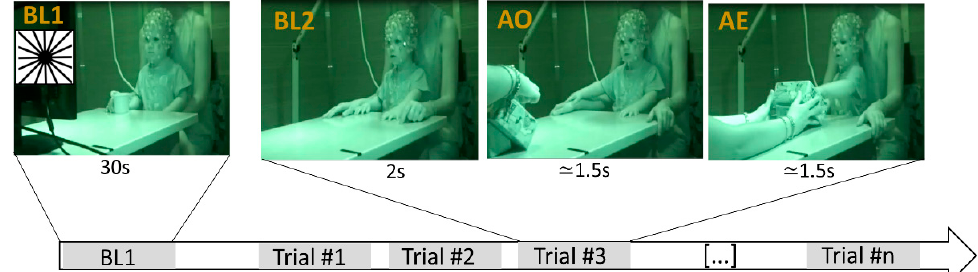
Figure 1. Experimental procedure. The procedure started with BL1, during which a static black and white image (reported in the figure in the top left corner) was presented for 30 s on a screen positioned in front of the participant. Successively, the toddler completed a series of identical trials, each comprising 3 events: BL2, in which the toddler quietly looked at the experimenter for 2 s; AO, in which the toddler observed the experimenter performing the button press action; AE, in which the toddler performed the button press action.